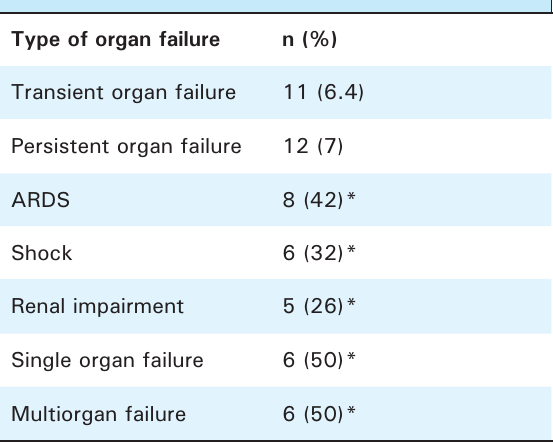
Table 2. Types of organ failure.